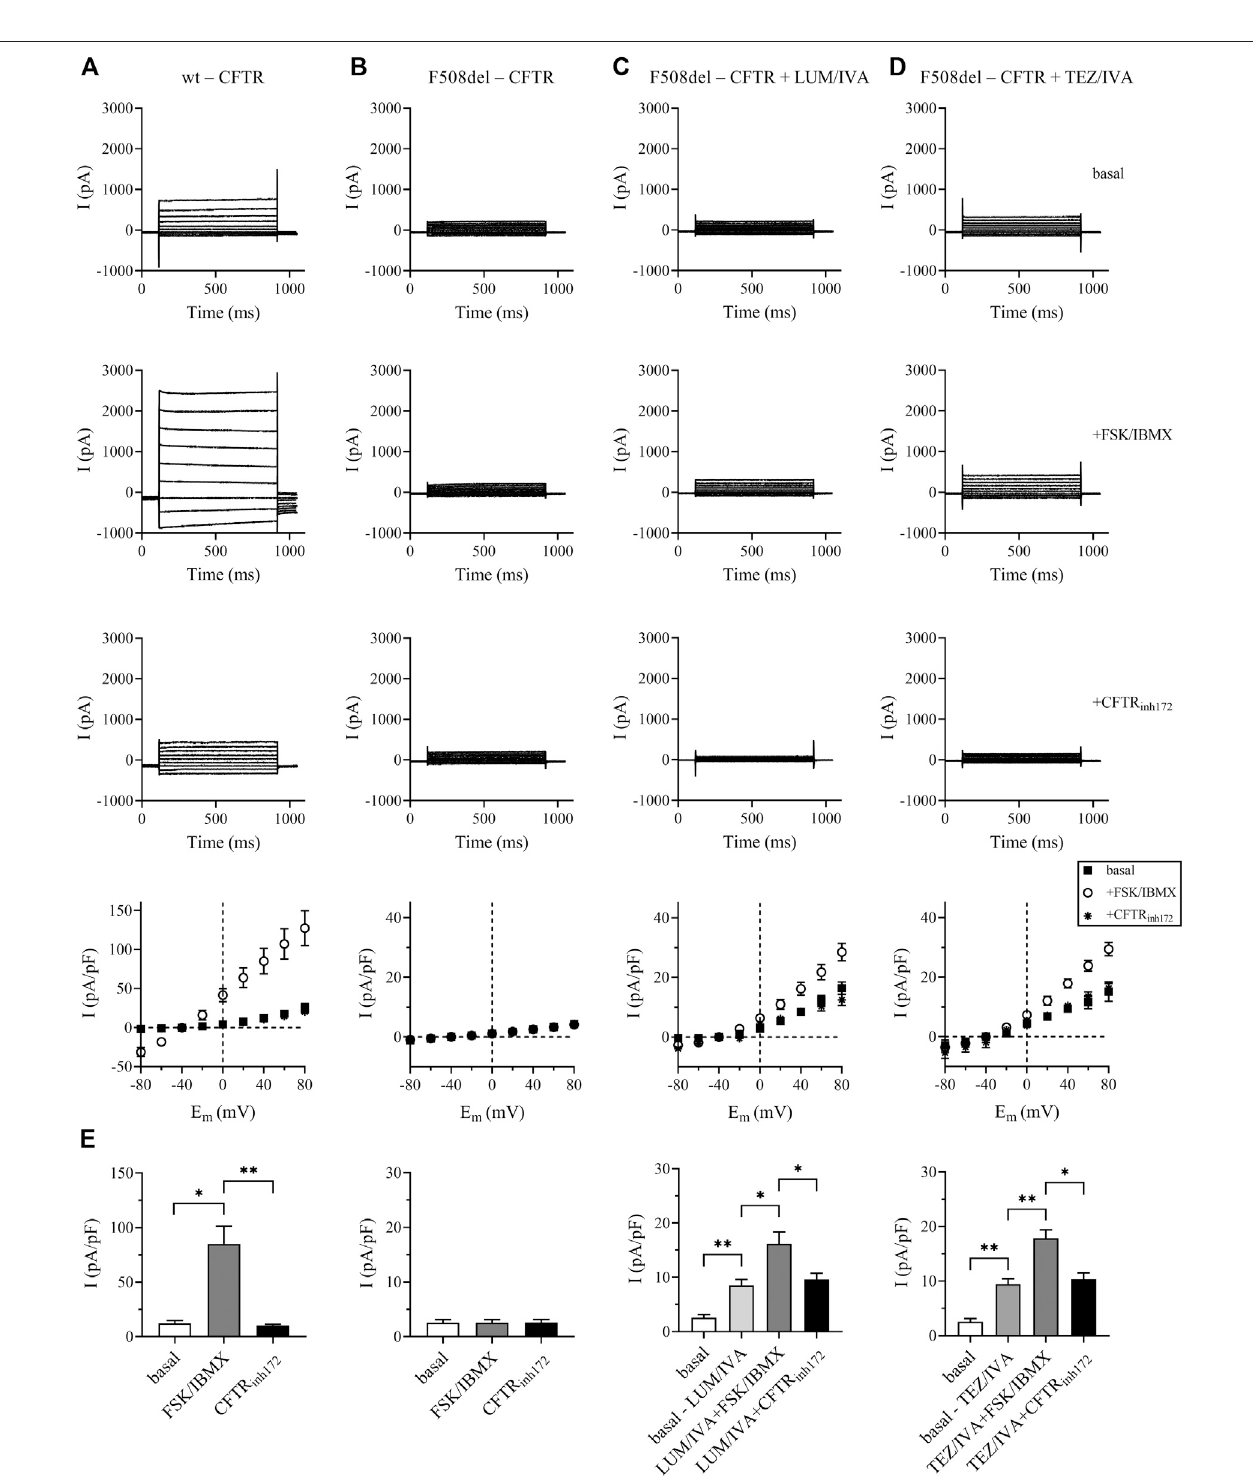
FIGURE 1 | Rescue of functional F508del-CFTR Cl − currents in LUM/IVA and TEZ/IVA-treated CFBE 41o − cells. Representative traces of whole-cell Cl − currents were elicited by stepping from a holding potential of − 40 mV to series test potentials ranging from − 80 to +80 mV with 20-mV increments every 10 s in CFBE 41o − cells expressing the wild-type CFTR [wt-CFTR, column (A) ], the F508del-CFTR [F508del-CFTR, column (B) ], or in cells expressing the deletion mutant CFTR but treated for 24 h with LUM/IVA [3/10 μ M, column (C) ], or TEZ/IVA [5/10 μ M, column (D) ]. Currents were measured at RT. Top traces: basal current, in the absence of FSK/ IBMX stimulation; middle traces: after ∼ 2 min stimulation by FSK/IBMX (10/100 μ M); bottom traces: in the presence of FSK/IBMX and 20 μ M of the CFTR inhibitor